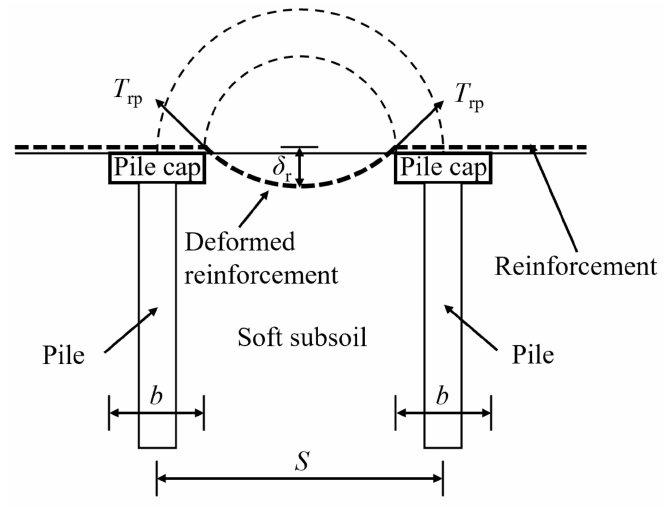
Figure 2. Membrane action of